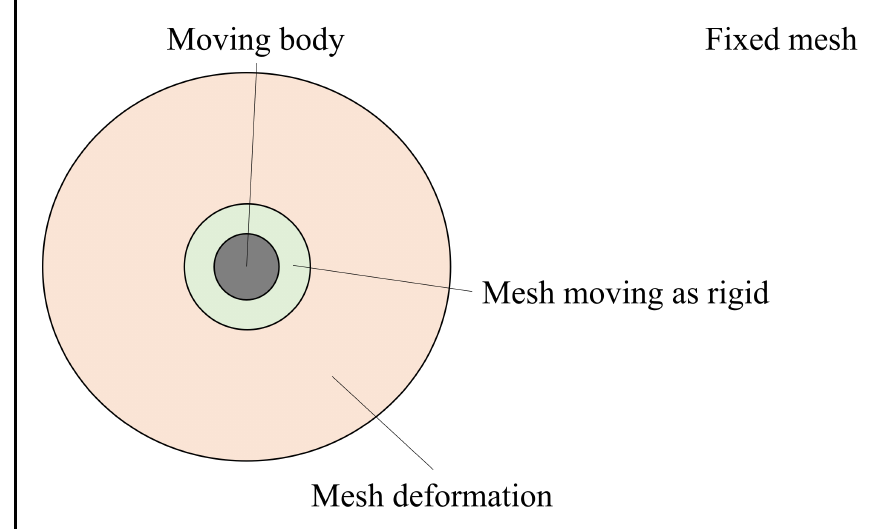
Figure 7. Schematic describing the components of a mesh moving